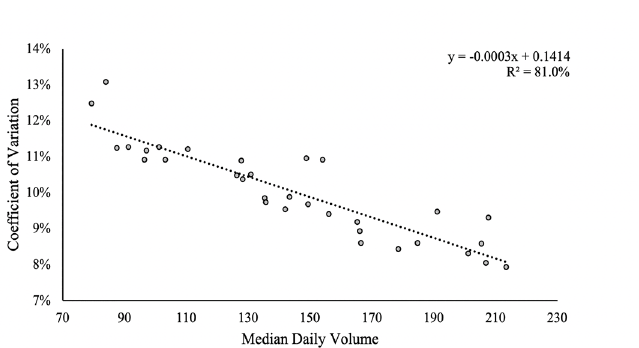
Figure 1. Regression analysis for coefficient of variation and median daily volume by emergency department: The coefficient of variation, which is equal to the standard deviation divided by the mean, is the dependent variable, while median daily volume for EDs is the independent variable. The results indicate a strong negative linear correlation with R 2 of 81.0%.